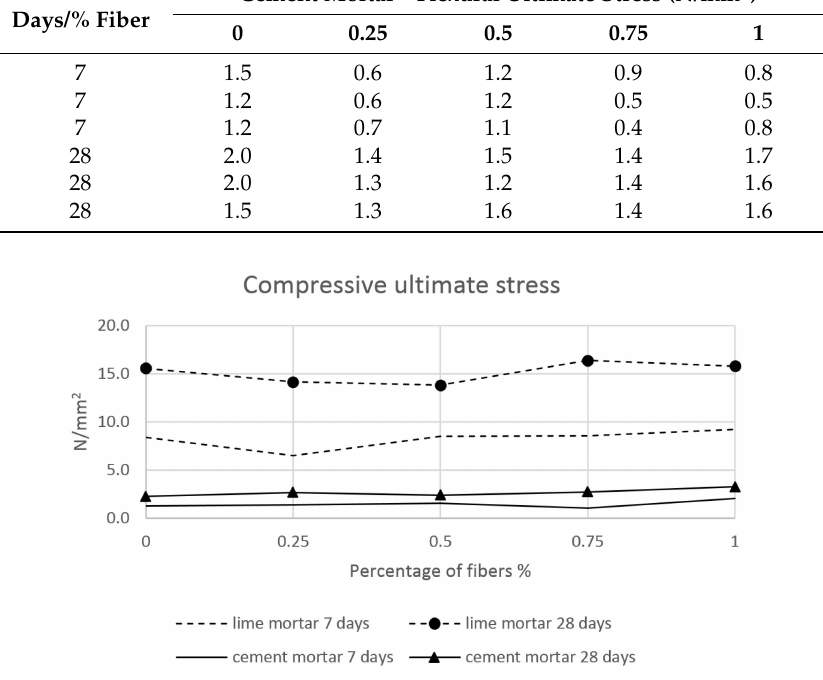
Figure 8. Compressive test